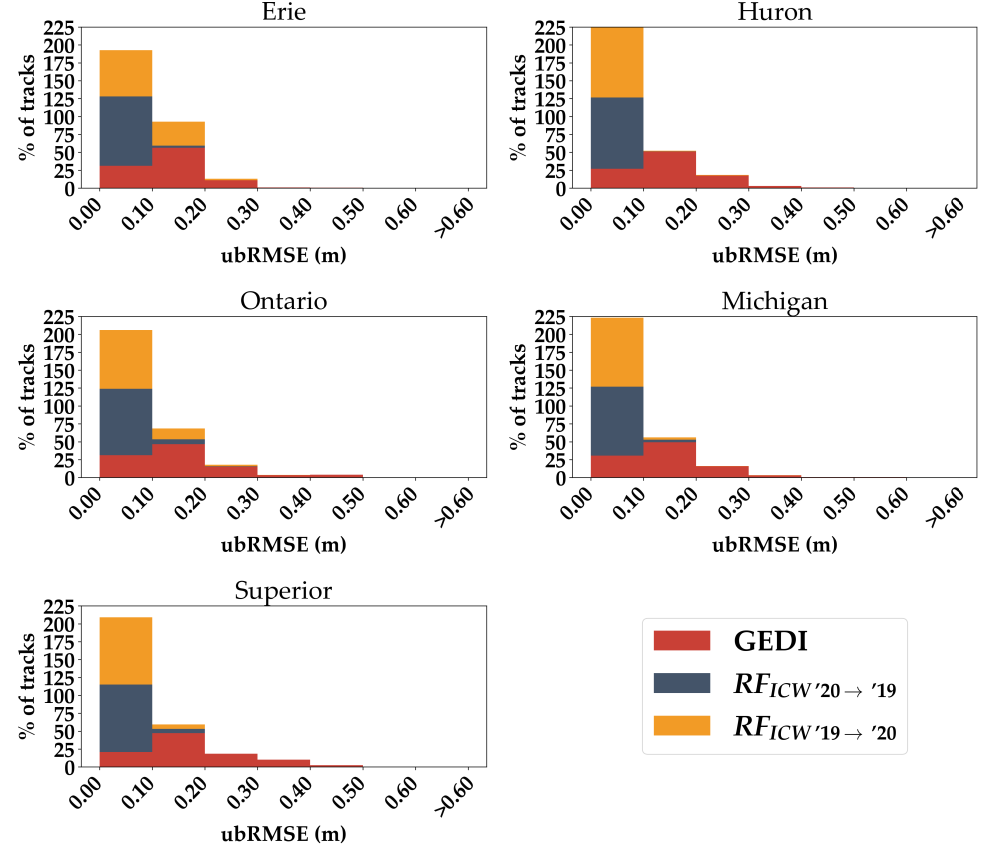
Figure 9. Stacked histograms of the distribution of the unbiased root mean squared error (ubRMSE) between GEDI (resp. 𝑅𝐹 𝐼𝐶𝑊 ′19→′20 and 𝑅𝐹 𝐼𝐶𝑊 ′20→′19 ) and in situ elevations across the five studied lakes. The distribution corresponds to the ubRMSE of GEDI shots grouped by acquisition date and the acquiring beam. 𝑅𝐹 𝐼𝐶𝑊 ′19→′20 (resp. 𝑅𝐹 𝐼𝐶𝑊 ′20→′19 ) corresponds to the 𝑅𝐹 𝐼𝐶𝑊 model, trained over 2019 (resp. 2020) data and validated on 2020 data (resp. 2019).